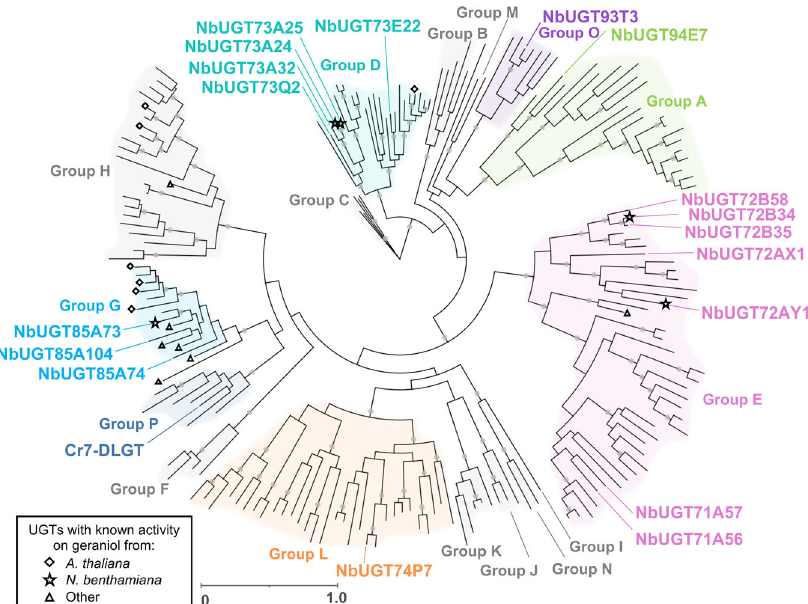
Fig. 2 Maximum likelihood (RAxML) phylogenetic comparison of 193 Family 1 UDP-glycosyltransferases (UGTs) from N. benthamiana and A. thaliana and nine UGT sequences previously shown to be active on geraniol or iridoid substrates. Groups A-P are annotated according to the nomenclature used by Caputi et al. 2012 33 . Labeled taxa indicate enzymes in which Cas9-mediated targeted mutations were subsequently introduced. Filled gray circles at nodes indicate bootstrap supports >95. Scale bar represents the number of substitutions per site. A tree with all taxa and bootstrap values is provided in Supplementary Fig. 1.